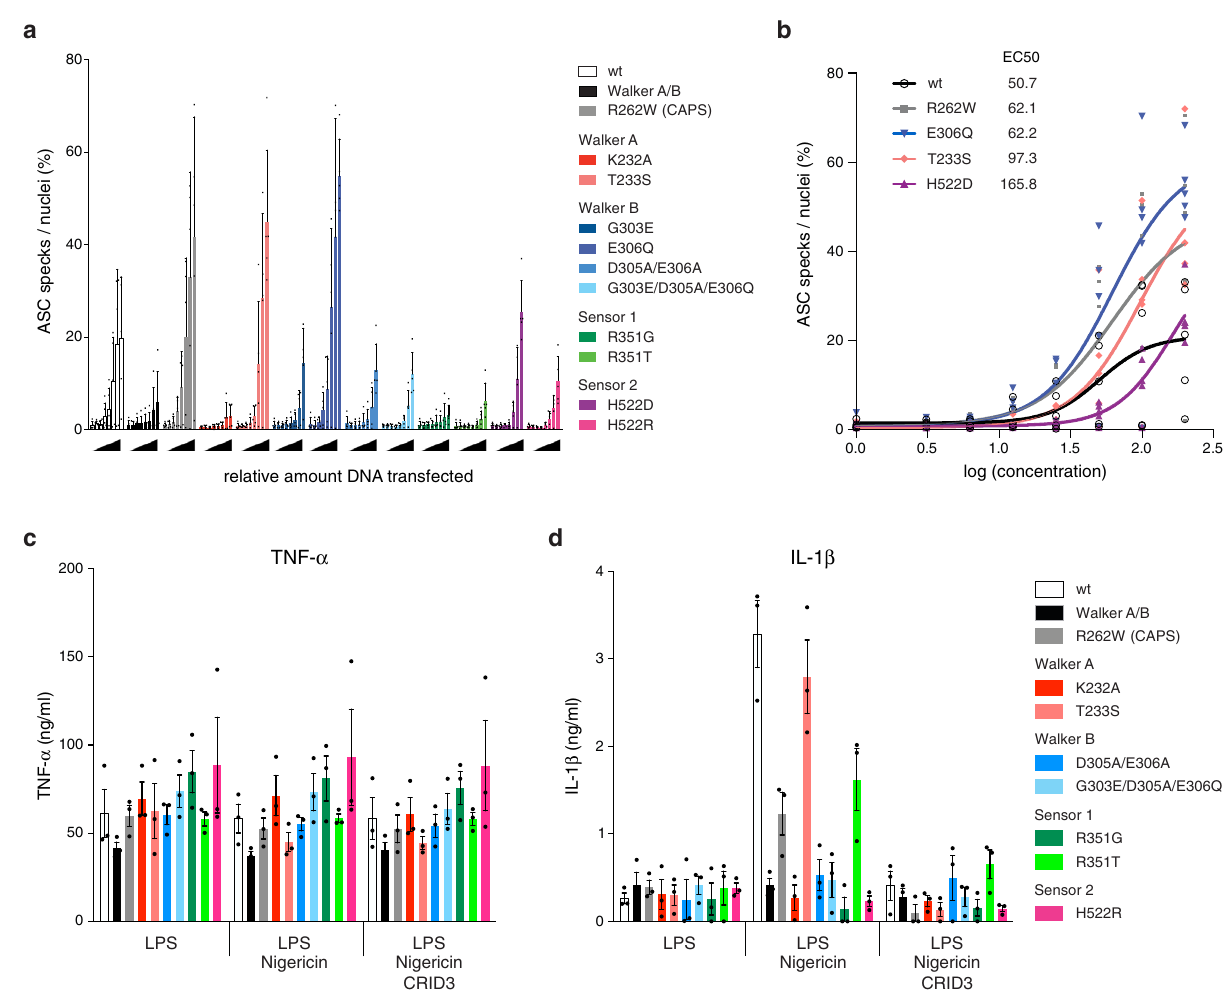
Fig. 5 Cellular activity assays for NLRP3 mutants targeting the AAA + ATPase fold. a Increasing amounts of different NLRP3 variants targeting the AAA + ATPase fold were transiently over-expressed in HeLa cells stably over-expressing ASC-mTurquoise. ASC specks and nuclei were quanti fi ed using microscopy, and the ratio ASC speck/nuclei was plotted as a measure of in fl ammasome activation. Bars represent mean and SD of 5 independent experiments. b Dose response curves for the active NLRP3 mutants described in a . The half maximal effective concentration (EC50) was calculated for each of the NLRP3 variants. Data points of 5 independent experiments are shown. c , d NLRP3-de fi cient immortalized macrophages were reconstituted with wildtype NLRP3-mCitrine or indicated variants. c TNF- α and d IL-1 β secretion of LPS primed immortalized macrophages stimulated with nigericin in the presence or absence of CRID3. Means ±SEM of pooled data from 3 independent experiments are